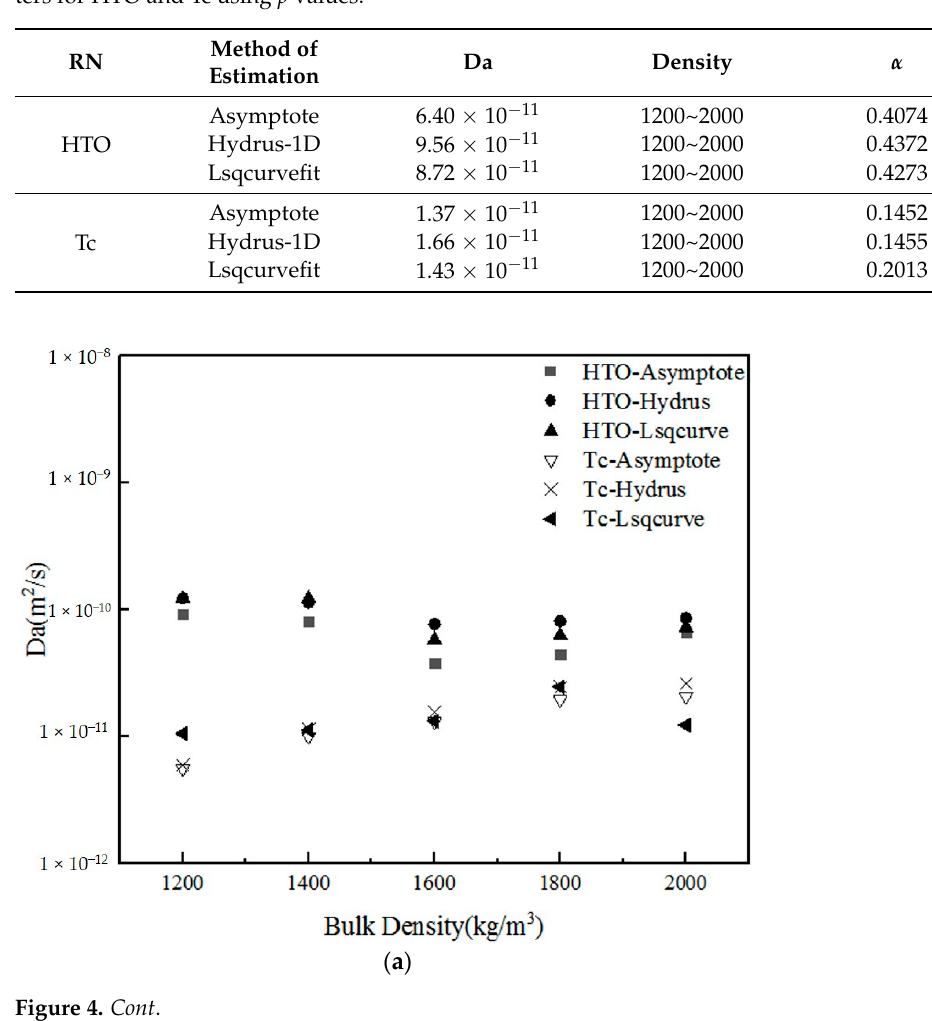
Table 2. Results of the statistical analysis of the influence of different methods and different parame- ters for HTO and Tc using p values.